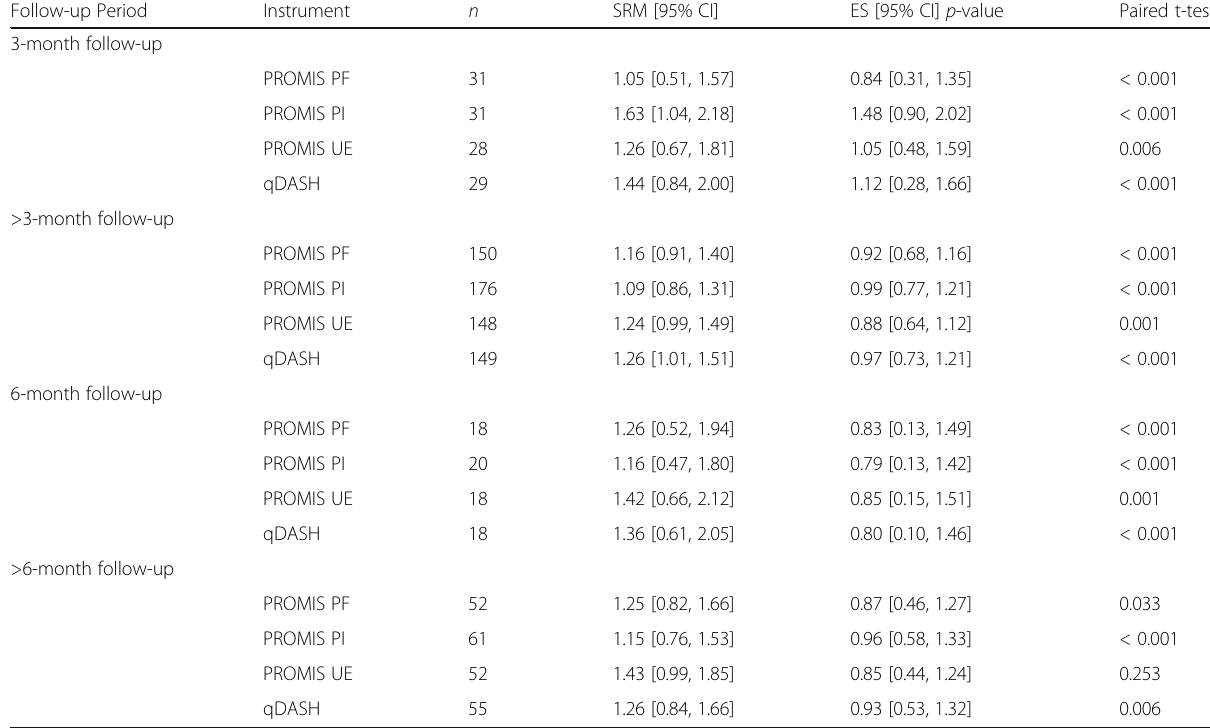
Table 4 Responsiveness of PROMIS instruments and qDASH of patients from